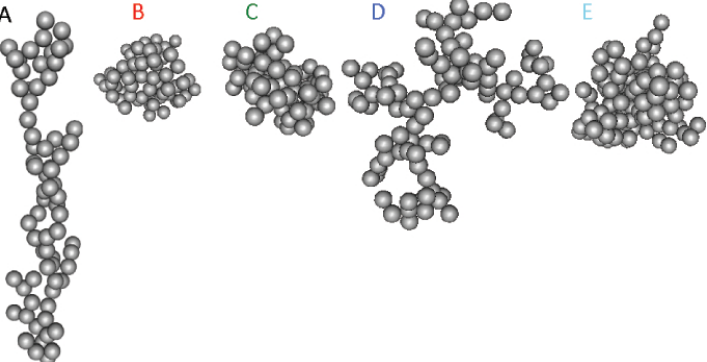
Fig. 2. Visual representation of modeled bare BC. The labels A–E are color coded to match the legends in Fig. 3. Case A is a lacy structure of 70 monomers with diameters of 40nm. Case B is a compact structure of 64 monomers with diameters of 30nm. Case C is a compact version of case A. Cases D and E are aggregates of 100 monomers with diameters of 40nm, but with different compactness.